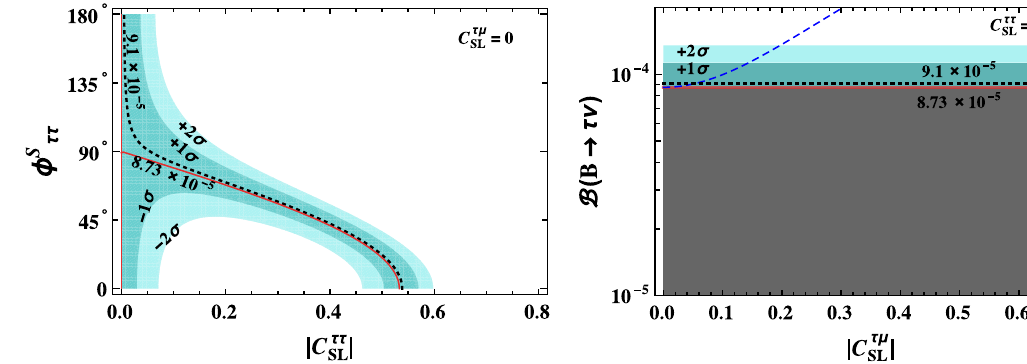
Fig. 2 Similar to Fig. 1, but for B → τ ¯ ν decay. See text for details